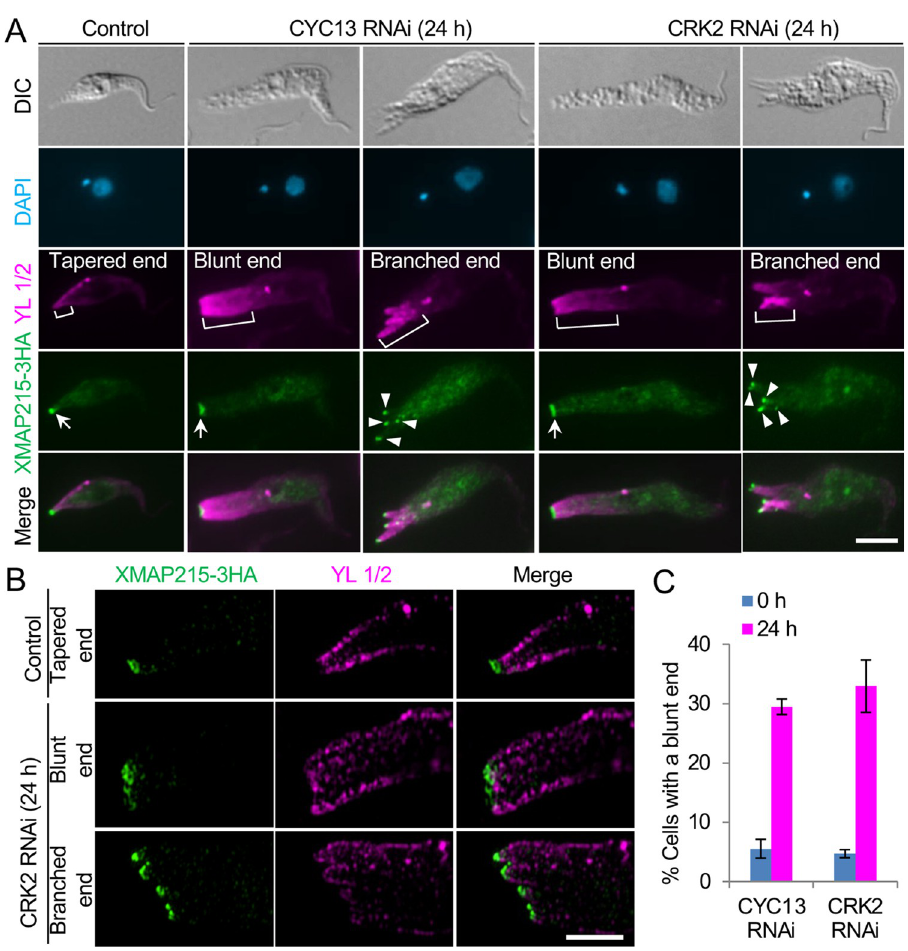
Fig 4. CYC13 and CRK2 are required for maintaining posterior morphology. ( A ). Immunofluorescence microscopy to examine the synthesis of new microtubules and the distribution of the microtubule plus-ends-binding protein XMAP215. Cells expressing endogenously 3HA-tagged XMAP215 were immunostained with FITC- conjugated anti-HA antibody and YL 1/2 antibody. The brackets outline the intensively stained posterior by YL 1/2 antibody, and the arrows indicate the XMAP215-enriched posterior tip and branched posterior tips. Scale bar: 5 μ m. ( B ). 3D-SIM super-resolution microscopic analysis of the posterior tip of control and CRK2 RNAi cells. Cells expressing XMAP215-3HA were co-immunostained with FITC-conjugated anti-HA antibody and YL 1/2 antibody. Scale bar: 5 μ m. ( C ). Quantitation of control, CYC13 RNAi, and CRK2 RNAi cells with a blunt posterior end. Error bars indicate S.D. from three independent biological